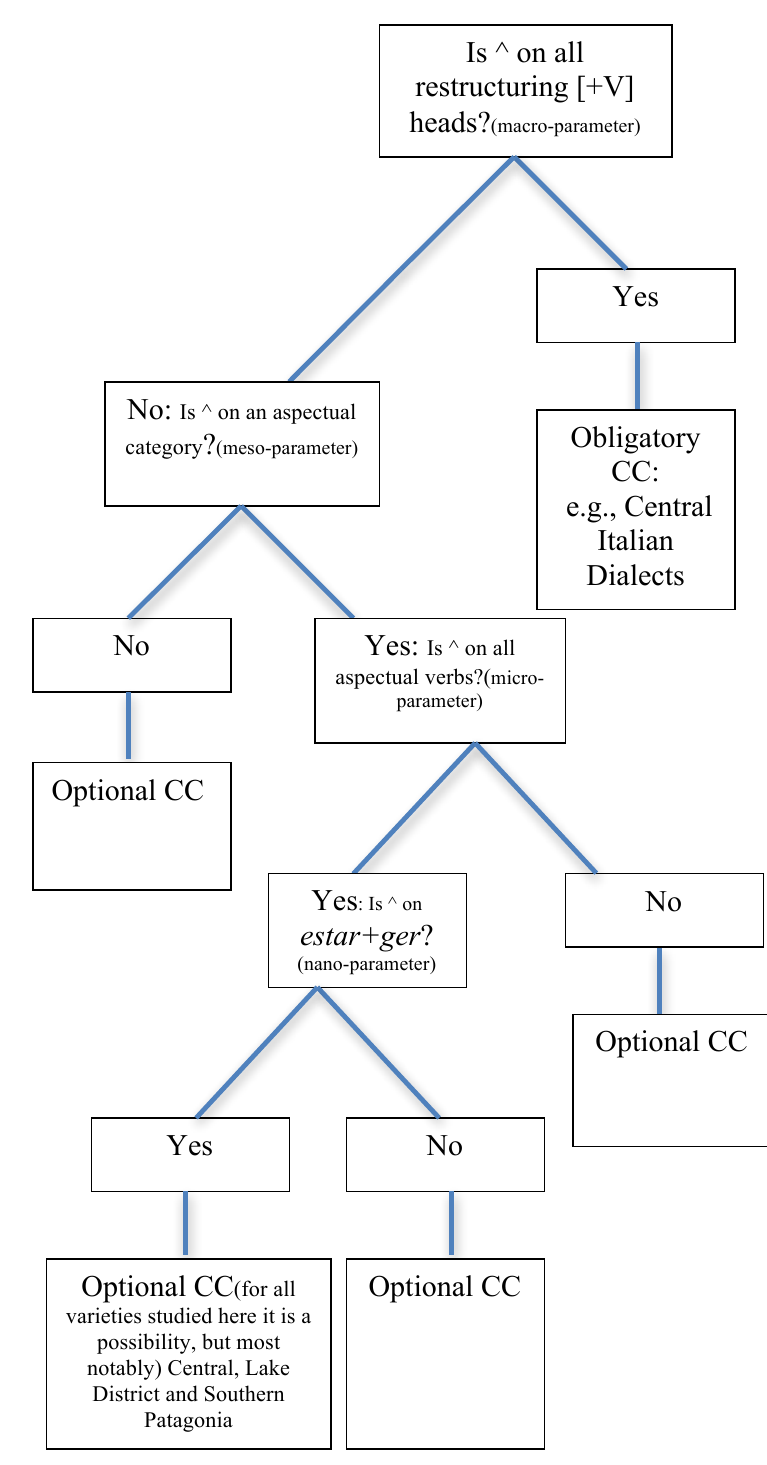
Figure 4 . Nano/micro/meso/macro-variation and